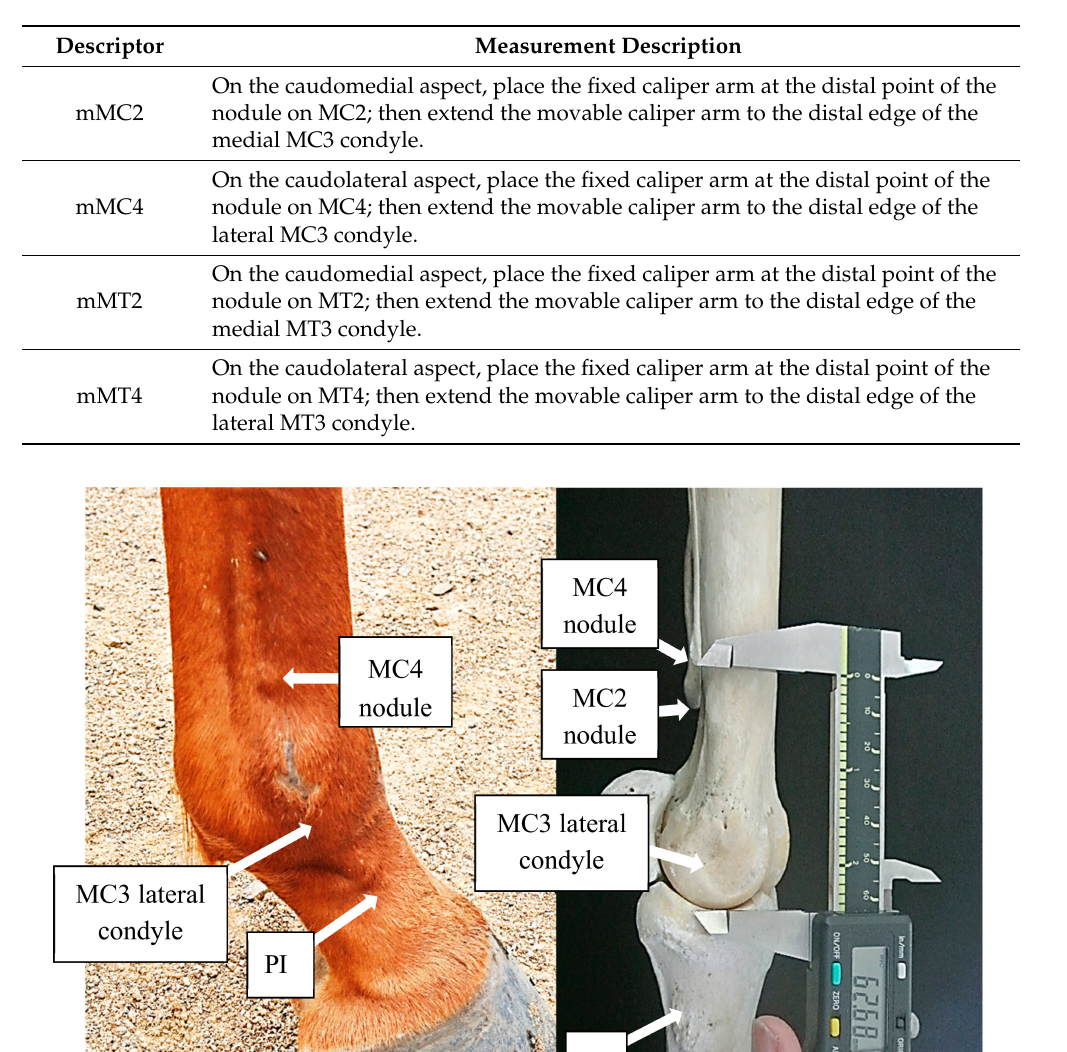
Table 1. Measuring techniques for mMC2, mMC4, mMT2 and mMT4.